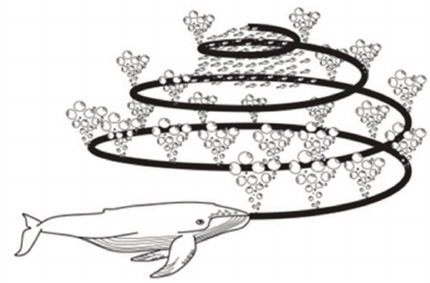
Figure 4. Diagram of humpback whale hunting